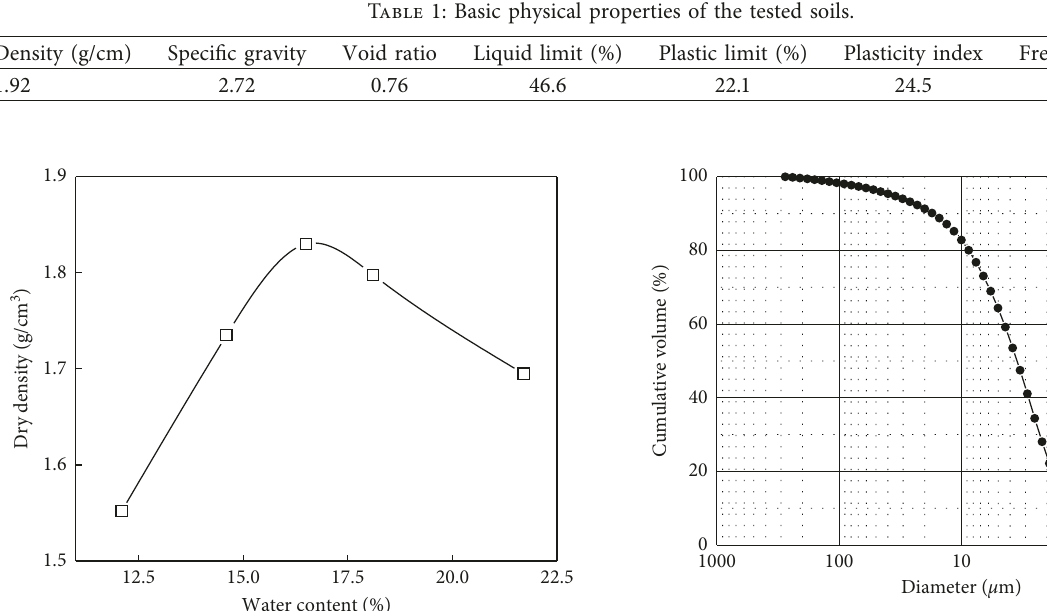
Figure 2: Compaction curve of the tested soils.